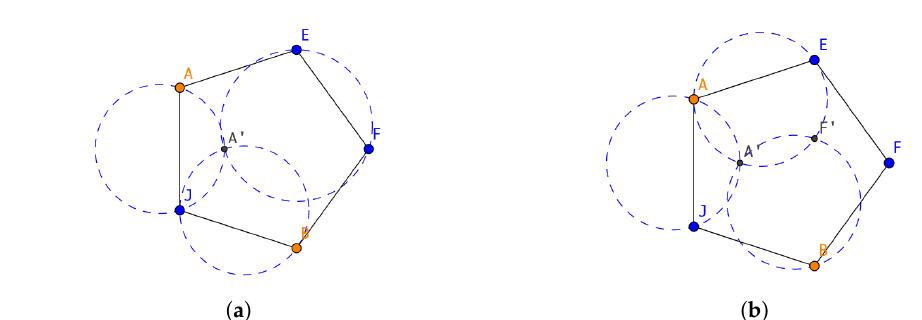
Figure 4. Analysis of the first 2 point insertions into the pentagon. ( a ) Insert the 1st point into the pentagon; ( b ) insert the 2nd points into the pentagon.